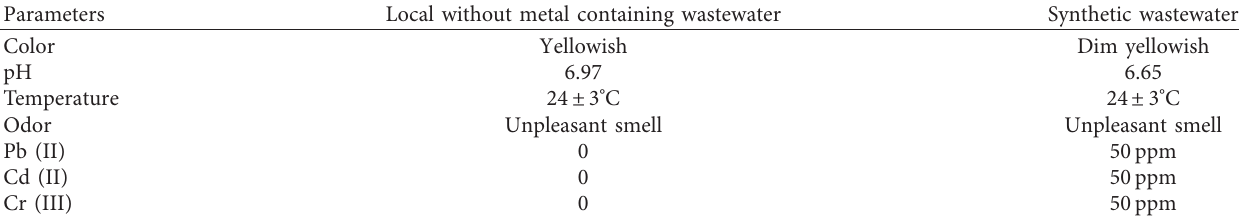
Table 1: Physicochemical characteristics of local untreated wastewater and synthetic wastewater.